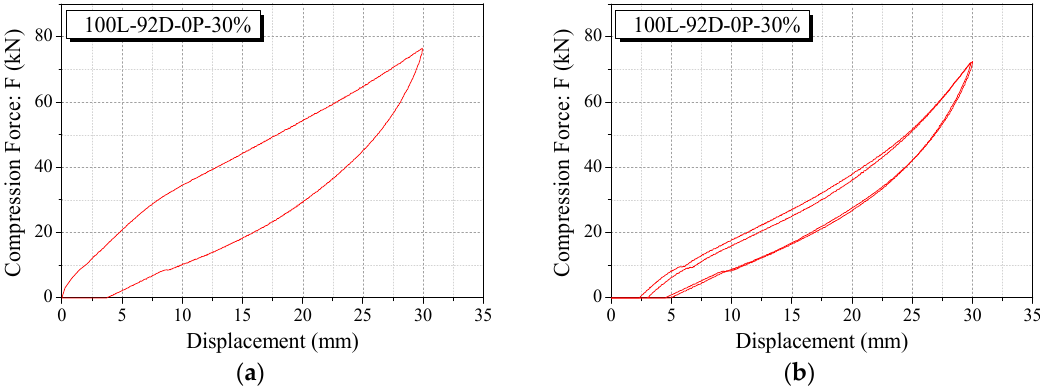
Figure 6. Force-displacement curve cycle separation. ( a ) Behavior of 1st cycle; ( b ) behavior of 2nd and 3rd cycle. As can be seen in Figure 7, within the same maximum strain, the maximum force (F max ) tended to increase when the length of the specimen increased. The length conditions